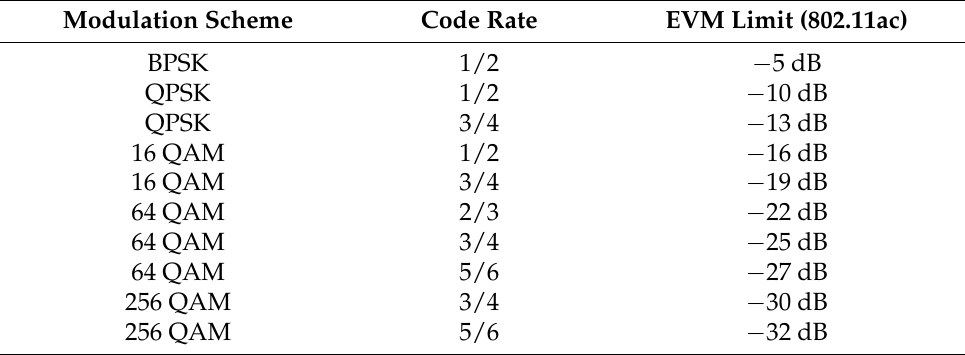
Table 6. EVM limits for a typical exemplary OFDM system: 802.11ac. [52] Modulation Scheme